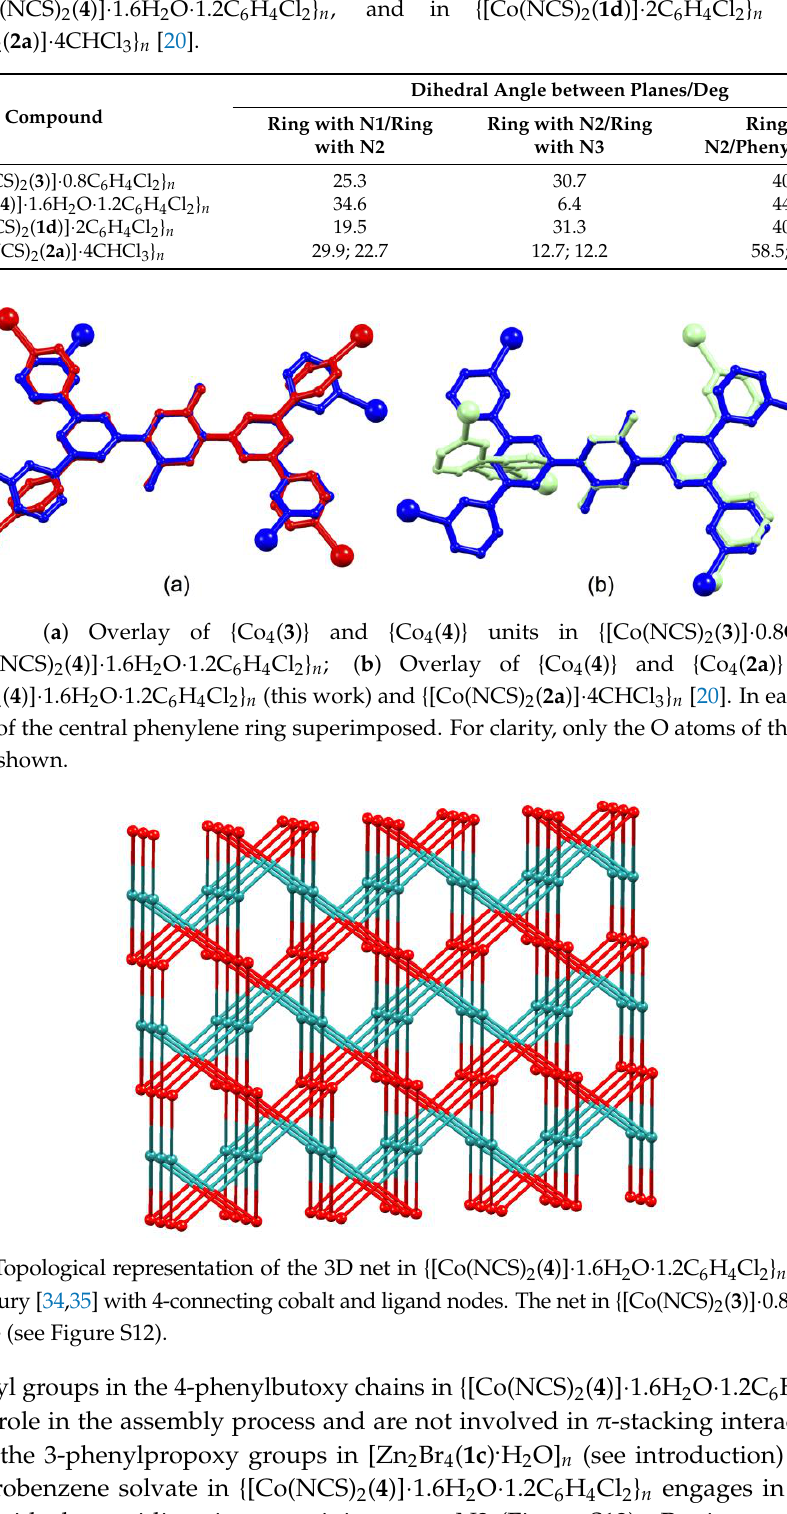
Table 2. Dihedral angles between pairs of bonded aromatic rings in {[Co(NCS) 2 ( 3 )]·0.8C 6 H 4 Cl 2 } n and